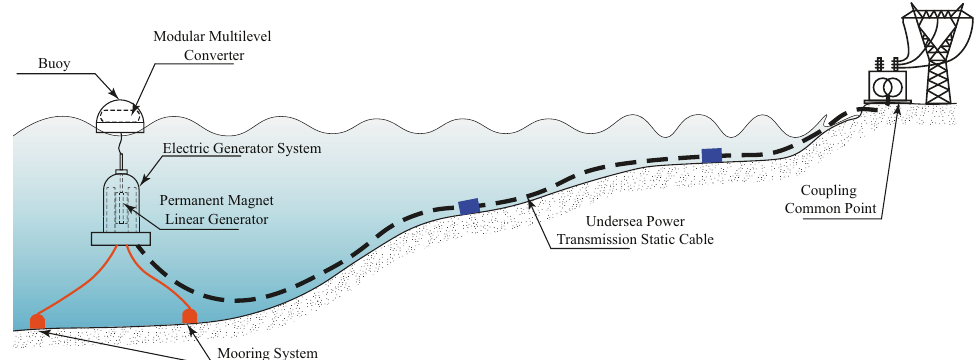
Figure 2. Complete system of a wave energy